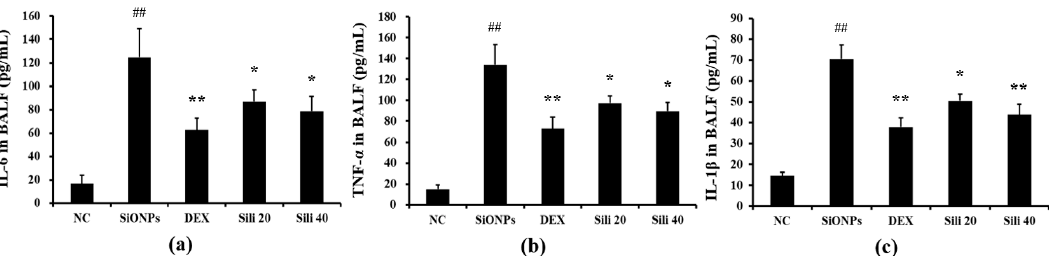
Figure 5. Effects of silibinin treatment on cytokines levels in BALF from mice exposed to SiONPs. ( a ) IL-6 level in BALF, ( b ) TNF- α level in BALF, ( c ) IL-1 β level in BALF. NC, normal control mice treated with PBS only; SiONPs, mice treated with SiONPs intranasal instillation; DEX, mice treated with dexamethasone (2 mg/kg) + SiONPs intranasal instillation; Sili 20 and 40, mice treated with silibinin (20 and 40 mg/kg, respectively) + SiONPs intranasal instillation. Data are represented as means ± SD ( n = 6). ## p < 0.01 vs. NC group, * , ** p < 0.05 and < 0.01 vs. SiONPs group, respectively.